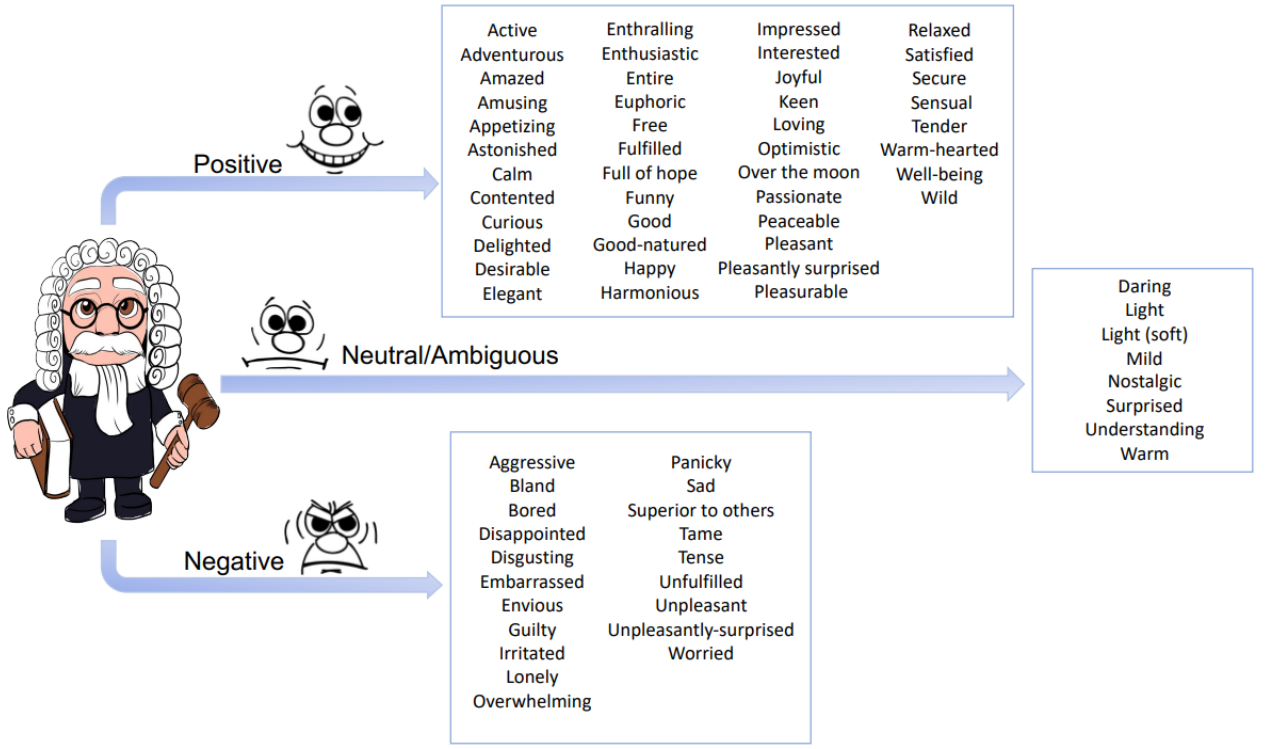
Figure 2. An example of Emotion lexicon evoked by wine. Data from [9].